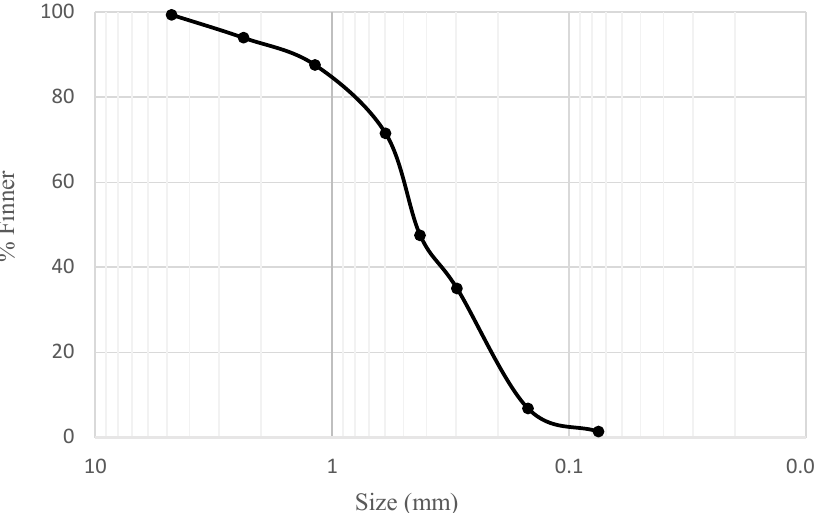
Figure 1. Gradation curve for dry sand.